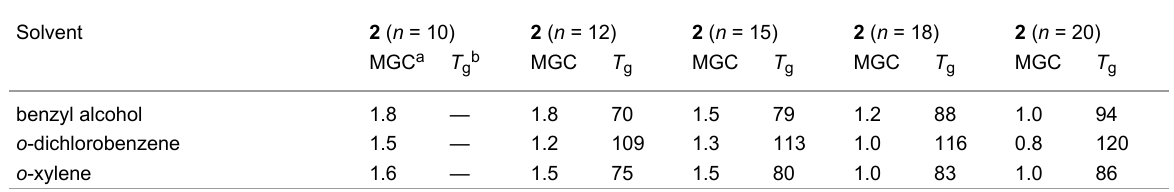
Table 2: Minimum gelation concentration and gel-to-sol transition temperature of compounds 2 ( n = 10, 12, 15, 18 and